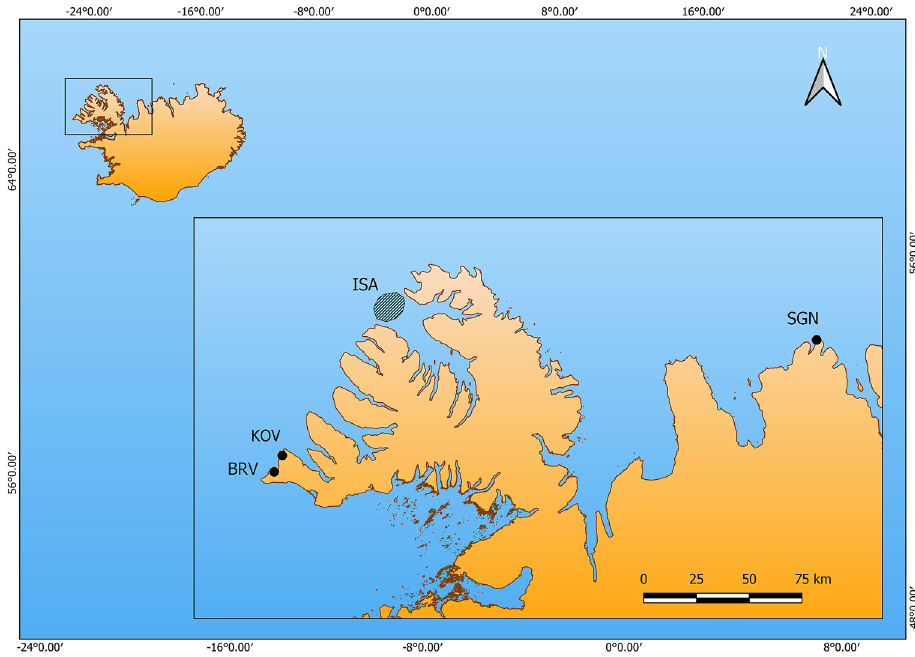
Figure 1. Map showing the excavation sites of Breiðavík (BRV), Kollsvík (KOV) and Siglunes (SGN) as well as the approximate position of the fishing grounds of the present-day comparison samples (ISA) indicated as a shaded